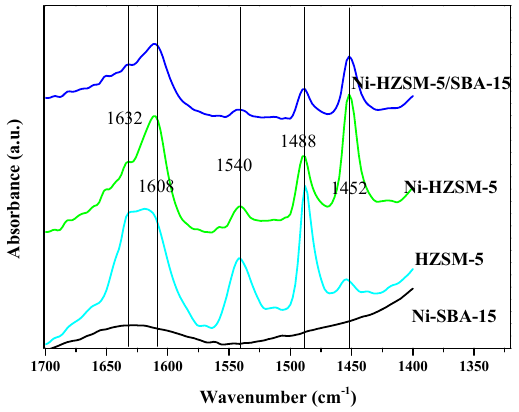
Figure 5. FTIR spectra at 573 K of different nickel catalysts after adsorption of pyridine